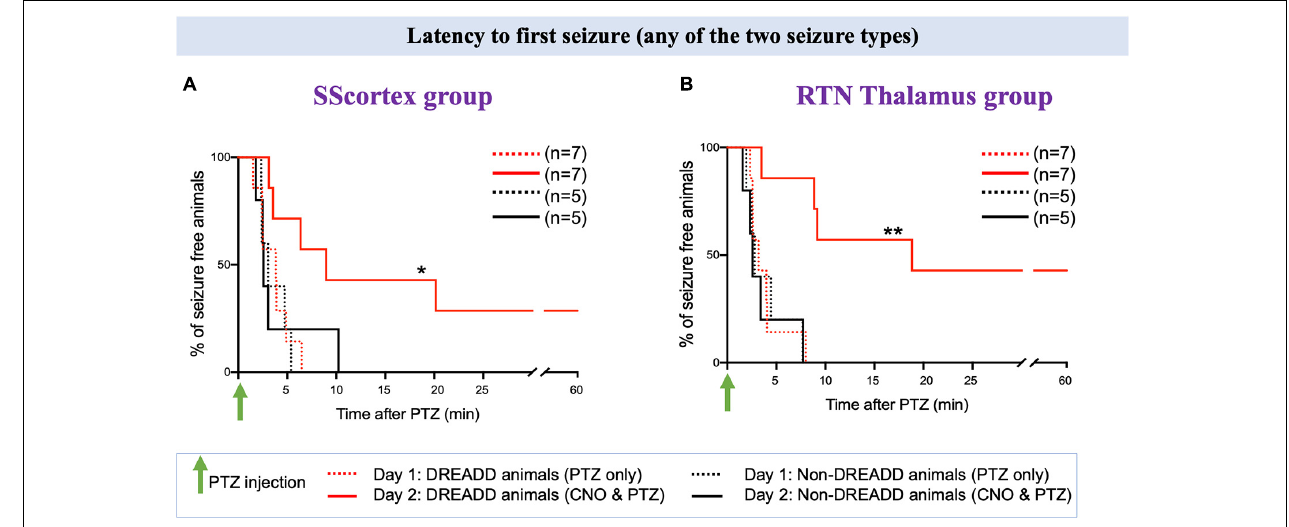
FIGURE 7 | Comparison of the latency to first seizure (any of the two seizure type) in PV Cre /Gq-DREADD and non-DREADD WT controls of the (A) SScortex group and the (B) RTN thalamus group between day 1 (PTZ only treated) and day 2 (CNO and PTZ treated). Comparisons between the treatment groups were made using